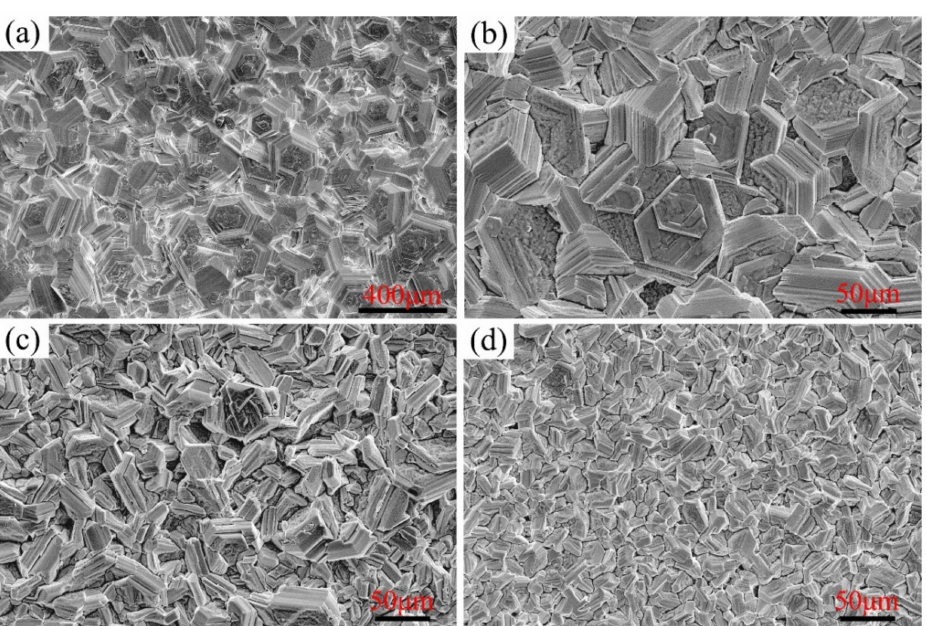
Figure 7. Secondary electron morphology of Ni–xCr–Mo laser-cladding coatings corroded for 168 h at 550 ◦ C: ( a ) C1, ( b ) C2, ( c ) C3, and ( d ) C4.